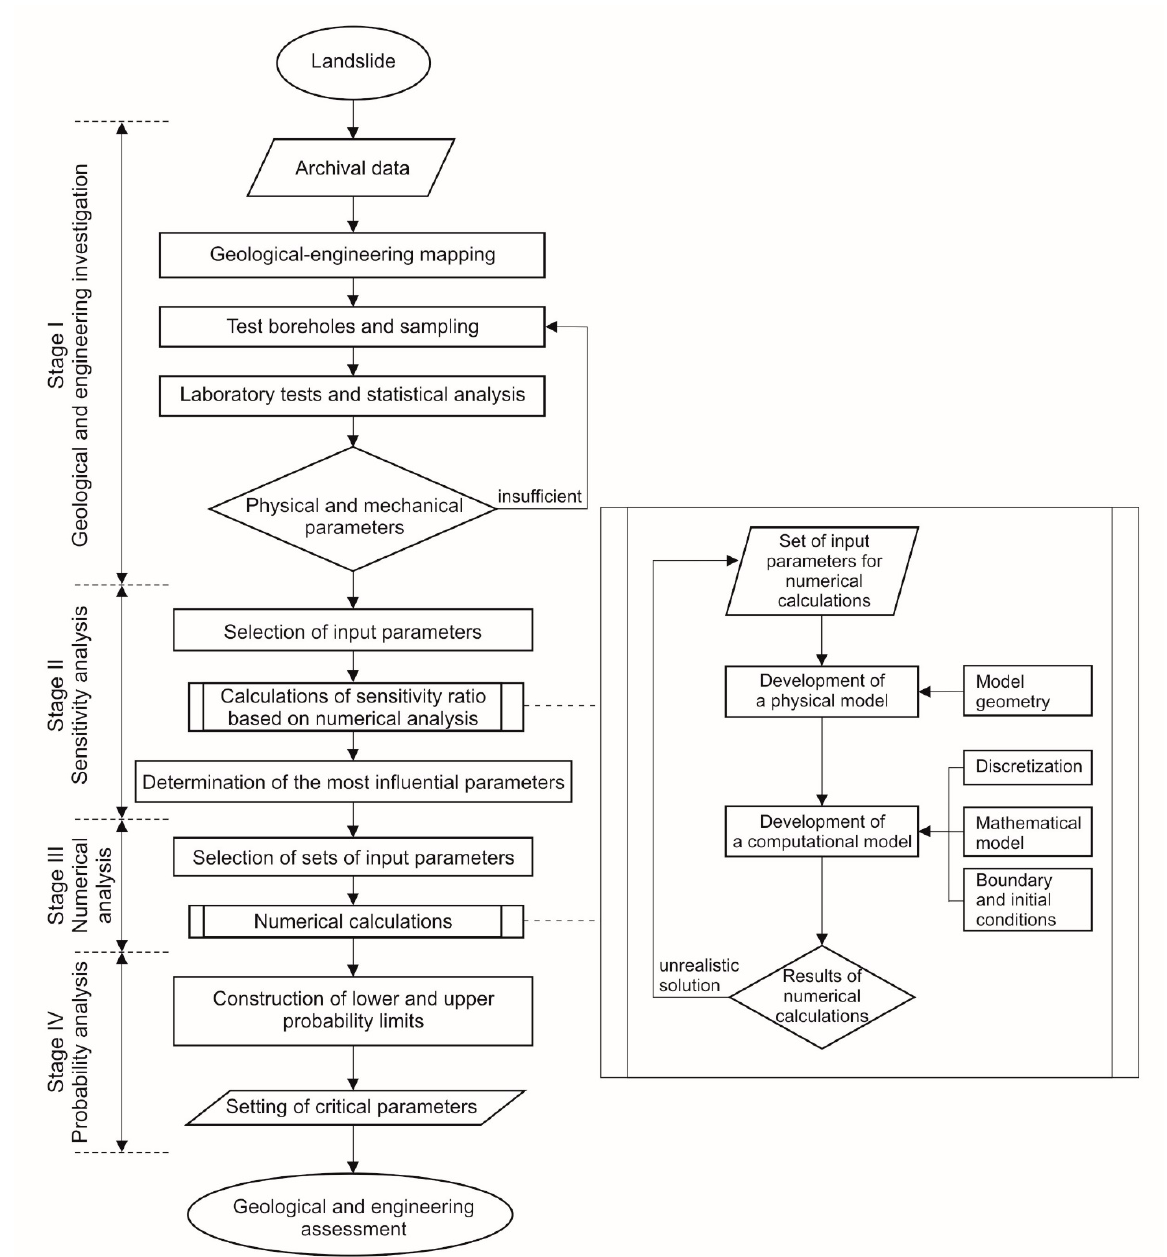
Figure 5. Scheme of the research methodology for the 18S landslide in the slope of the Be ł chatów open-pit mine.